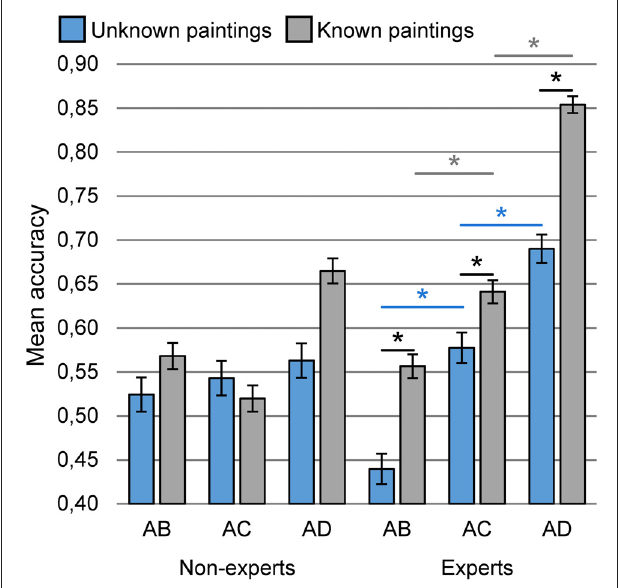
FIGURE 3 | The interaction of expertise, familiarity and difference between paintings in pair on accuracy of paintings evaluation during evaluation of two versions of the same painting in three pairs: AB, AC and AD. Vertical bars denote ± standard errors, ∗ means a significant